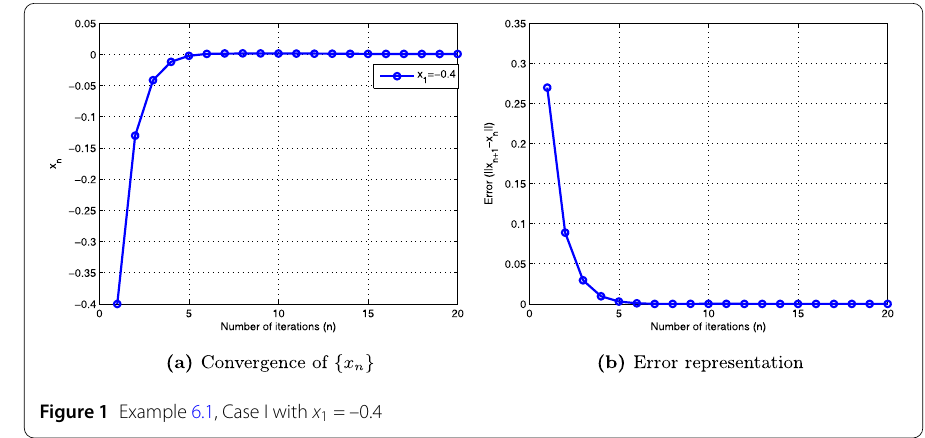
Figure 1 Example 6.1, Case I with x 1 = –0.4